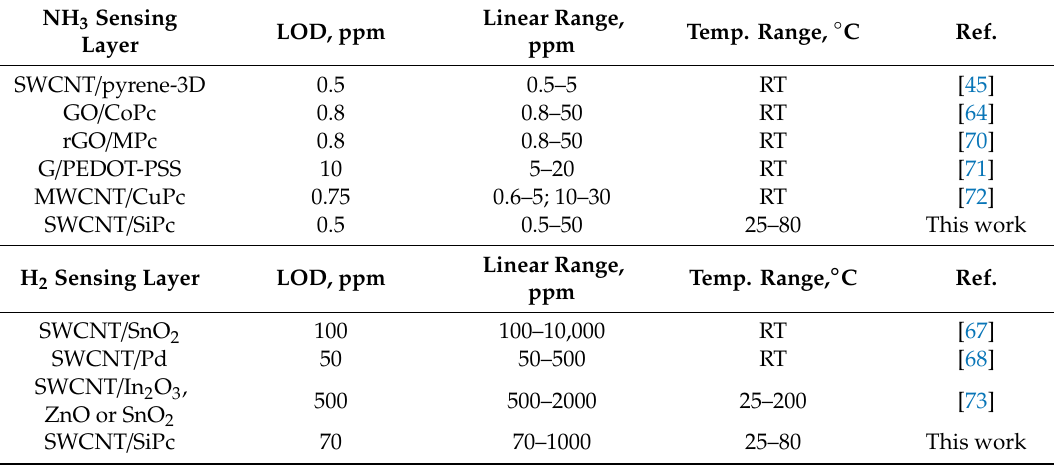
Table 1. Sensor characteristics of active layers based on carbon nanomaterials functionalized with metal oxides, phthalocyanines, and